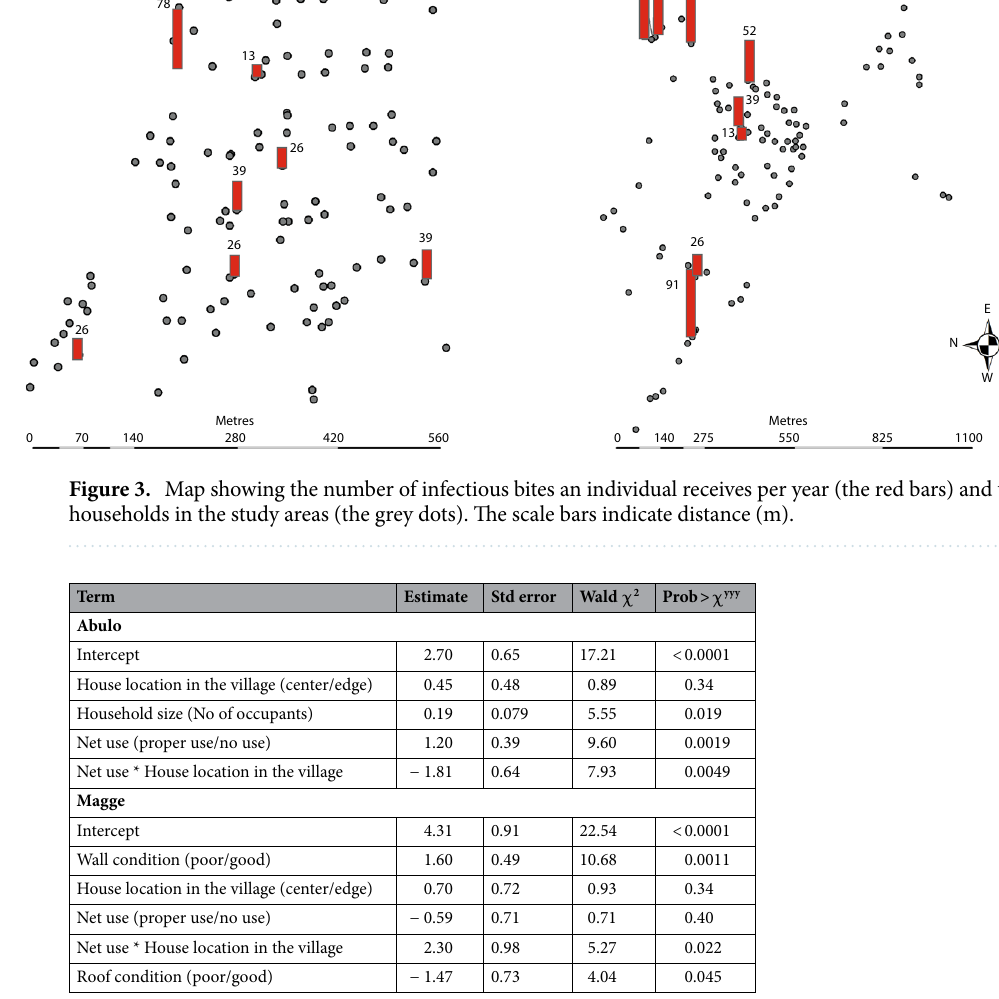
Table 2. Statistical summary of the effect of environmental variables on the density of indoor mosquitoes at the village level following stepwise backward selection and removal of non-significant independent variables.